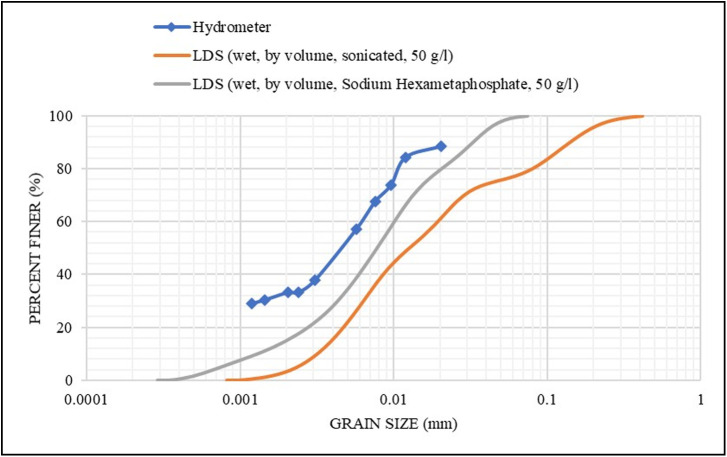
Effect of sample dispersion by sonication & Sodium Hexametaphosphate on the grain size distribution for S1.